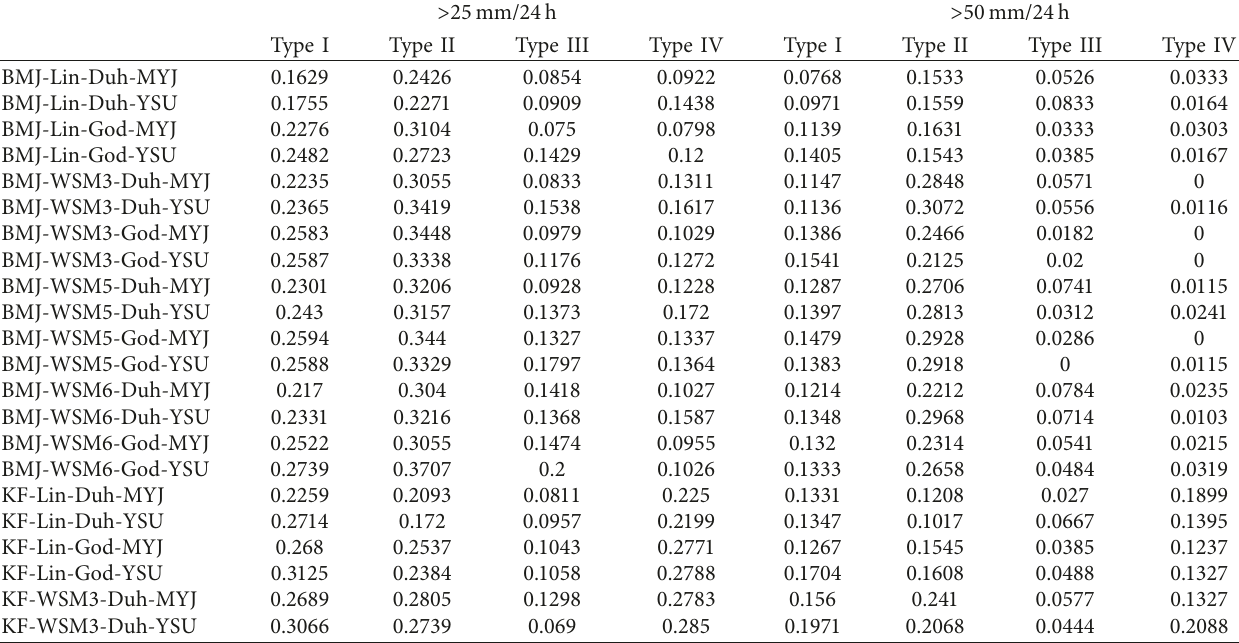
Table 8: TSs for different types of main heavy rainfall, at the 48 h forecast range for thresholds > 25mm/24 h and > 50mm/24 h, for the period